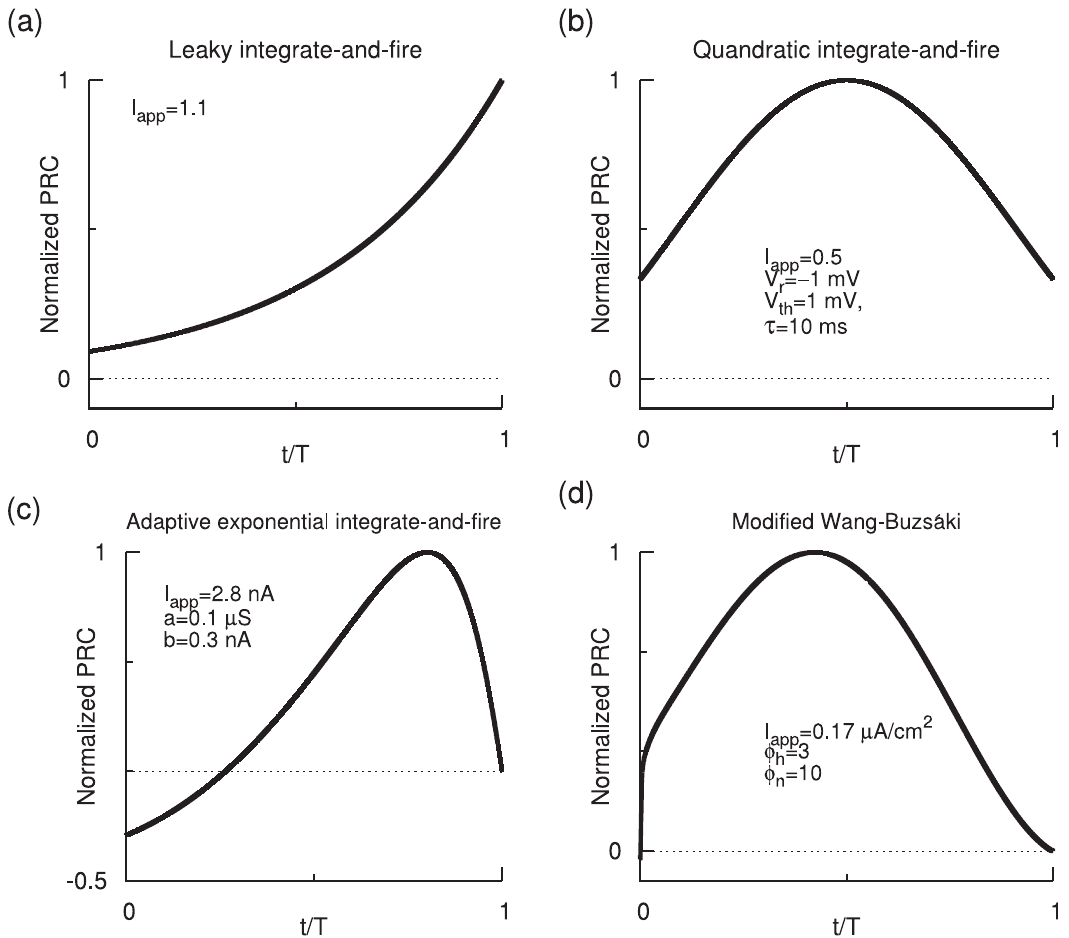
Figure 1. Prevalence of sharp jumps in the PRCs in some neuronal models. (a) PRC of leaky integrate-and-fire neuron model [22,35]: _ VV ~ I { V where V is reset to 0 when it crosses a threshold level of 1 (in normalized units). (b) PRC of quadratic integrate-and-fire neuron model app [23]: t _ VV ~ I app z V 2 where V is reset to V r when it crosses a threshold level V th . (c) PRC of adaptive exponential integrate-and-fire model